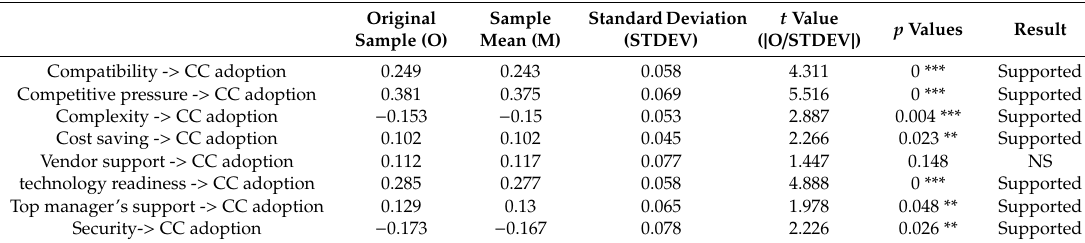
Table 7. Summary of hypothesis